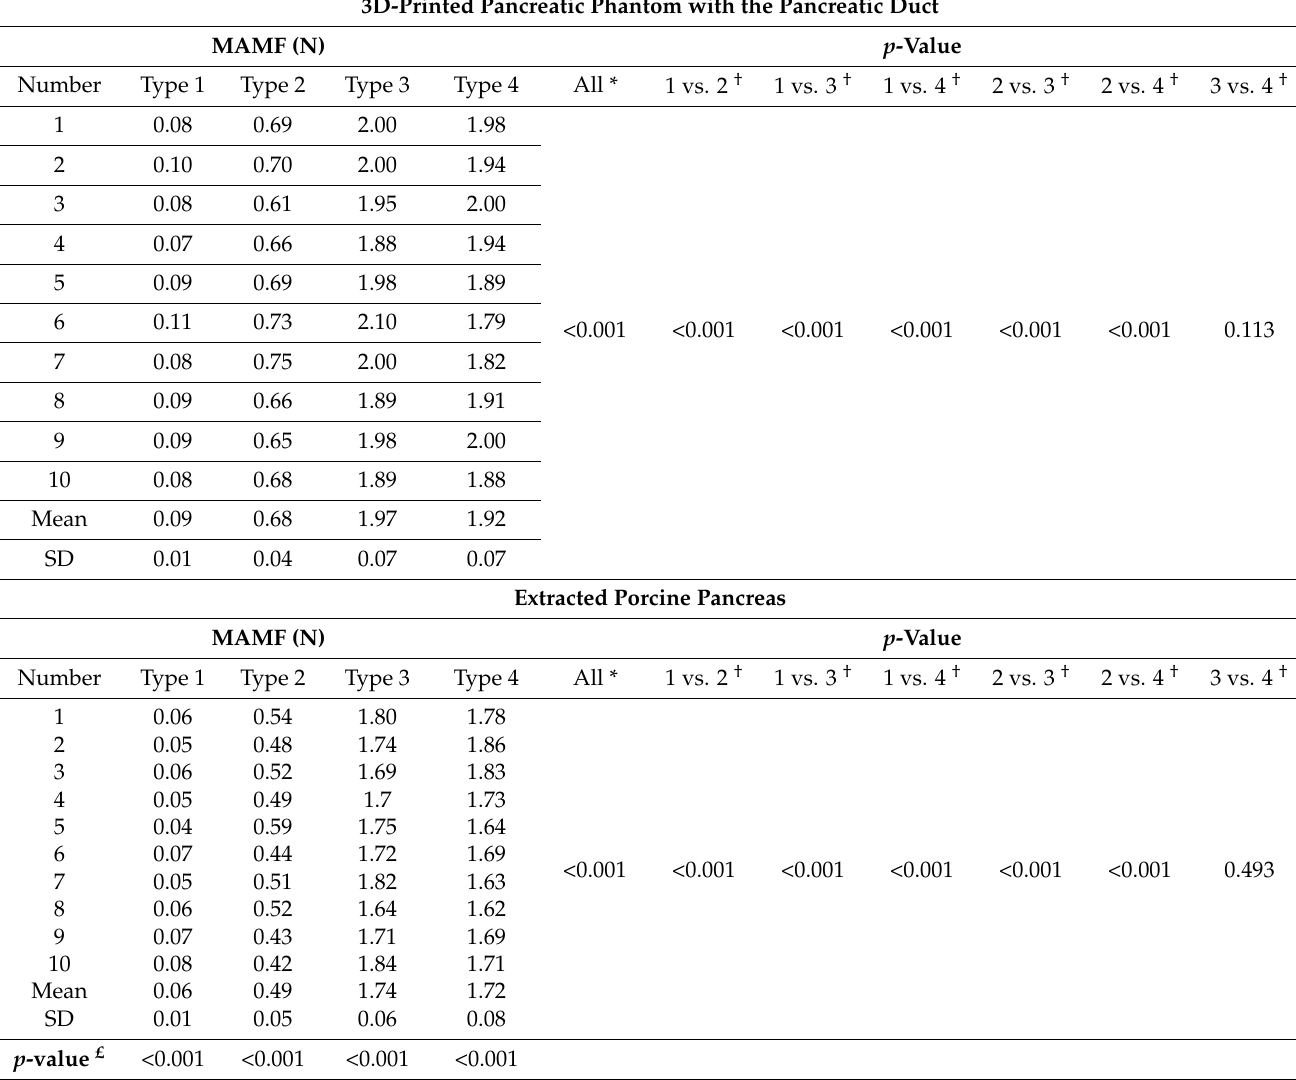
Table 2. The maximum antimigration force (MAMF) values in the 3D-printed pancreatic phantom with the pancreatic duct and the extracted porcine pancreas. 3D-Printed Pancreatic Phantom with the Pancreatic Duct p